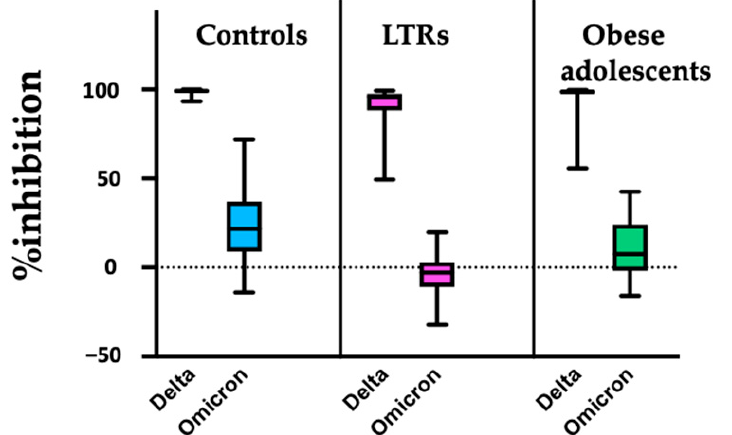
Figure 1. ( A ) The sVNT (%inhibition) to Delta variant ( B ) The SARS-CoV-2 total antibody after sec- ond dose of vaccination in healthy controls, LTRs, and obese adolescents.